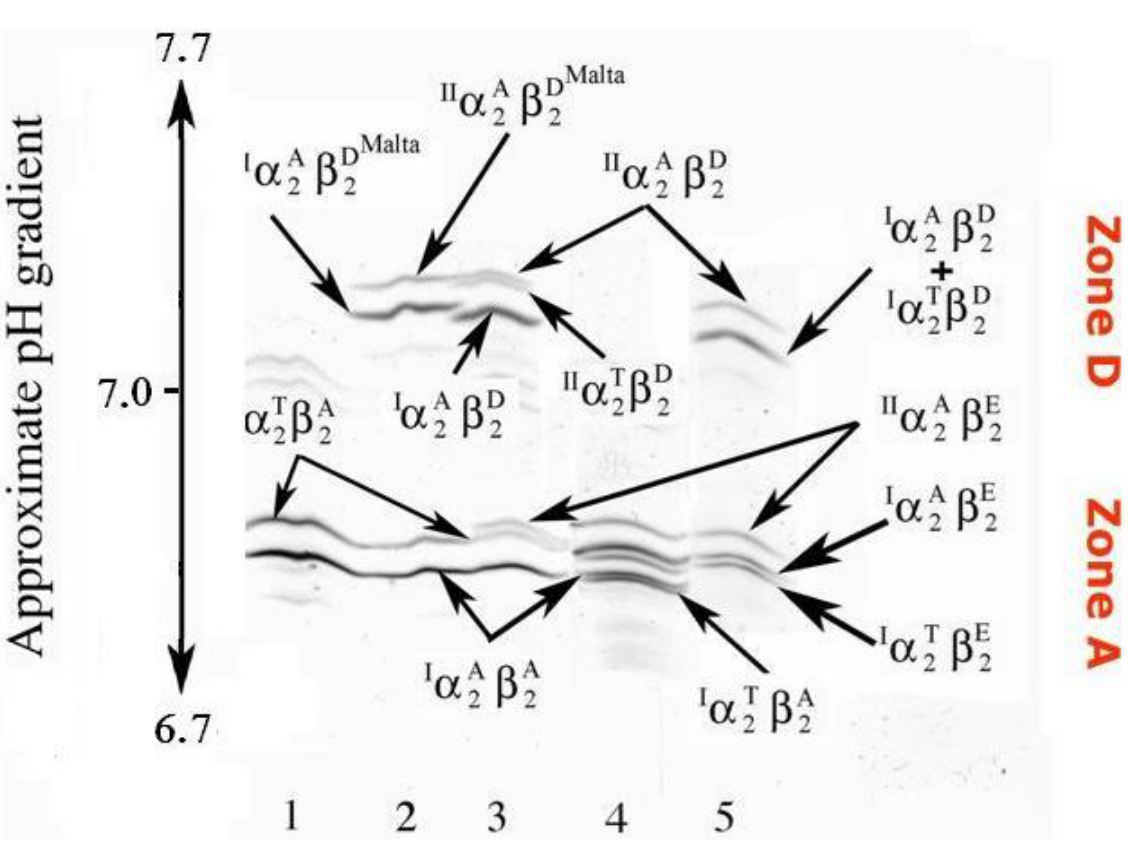
Figure 2. Polyacrylamide gel isoelectric (PAGIF) focusing on narrow pH range, 6.7–7.7, of goat hemoglobins carrying different α and β globin chains. Lane 1 : two non allelic alpha globins ( I α A and II α T ) and one beta globin (β A ) resulting in two Hb bands, I α A II α T β A ; Lane 2 : two non allelic alpha globins ( I α A and II α T ) and two beta globins (βA and 2 2 βD Malta ) resulting in a twin couple of Hb bands, the former couple migrating to zone A ( I α A β A and II α T β A ) and the latter to zone D ( I α A 2 2 2 2